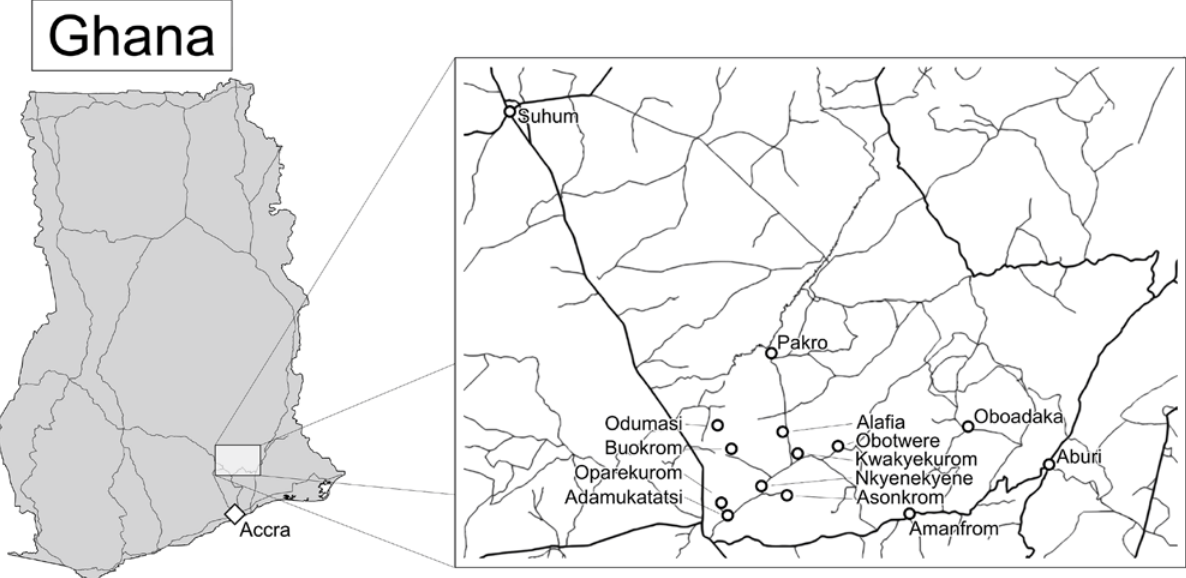
Figure 1. Map of Ghana indicating the region and communities from which the 19 BU patients colonized with S. aureus